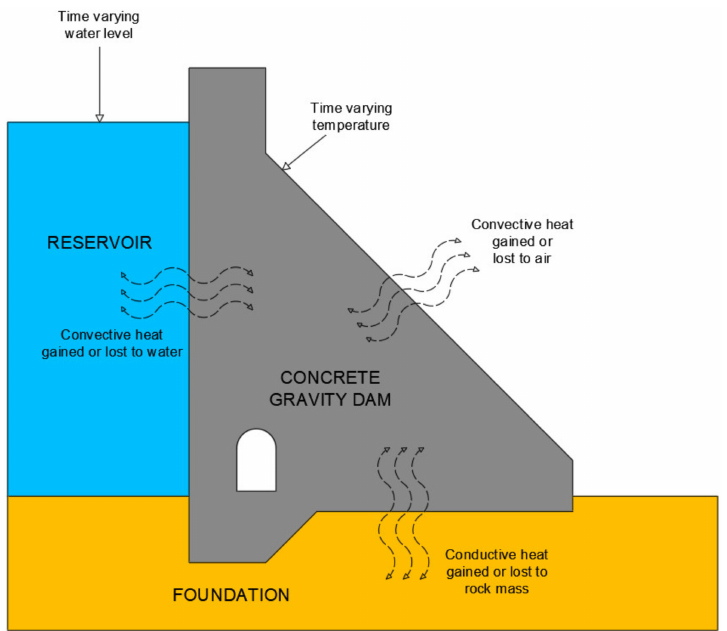
Figure 2. Heat transfer processes represented in this